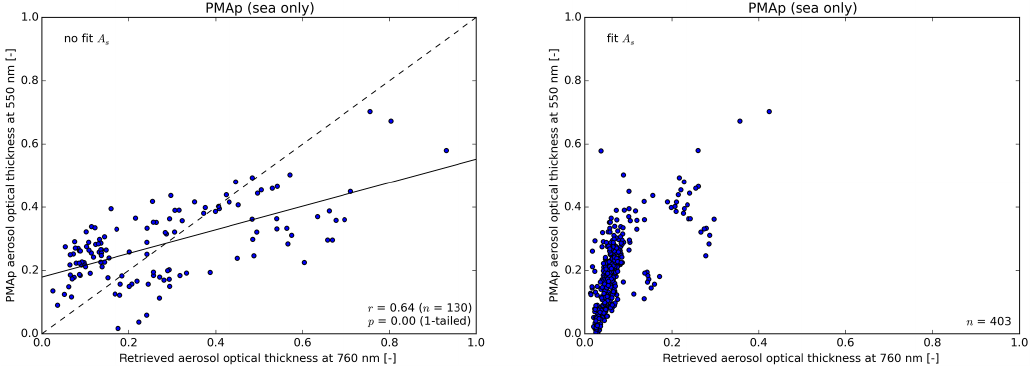
Figure 8. PMAp aerosol optical thickness at 550nm against aerosol optical thickness retrieved from the O 2 A band measured with GOME- 2A when the surface albedo is not fitted (left panel) and when it is (right panel). In these plots, PMAp aerosol optical thickness is the mean of valid PMAp retrievals (at least one) for PMD subpixels within the GOME-2A spectrometer’s footprint.